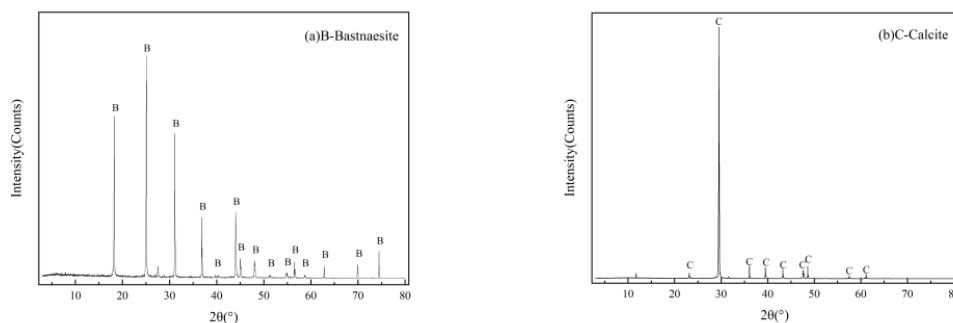
Figure 1. XRD spectra of bastnaesite ( a ) and calcite ( b ) particles. Table 1. Chemical composition of bastnaesite powder samples (weight %).